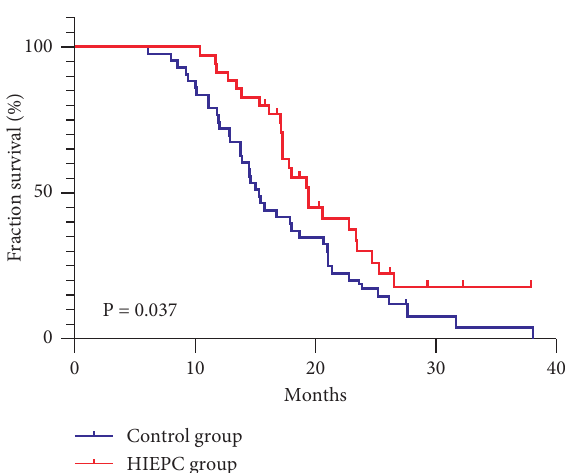
Figure 2: Cumulative survival of patients with control group patients and HIPEC group patients was determined by the Kaplan–Meier method. The median survival of the surgery combined with the gemcitabine treatment group in this study was 15.3 months. And the median survival time of patients treated with HIPEC was 19.2 months ( P � 0 .